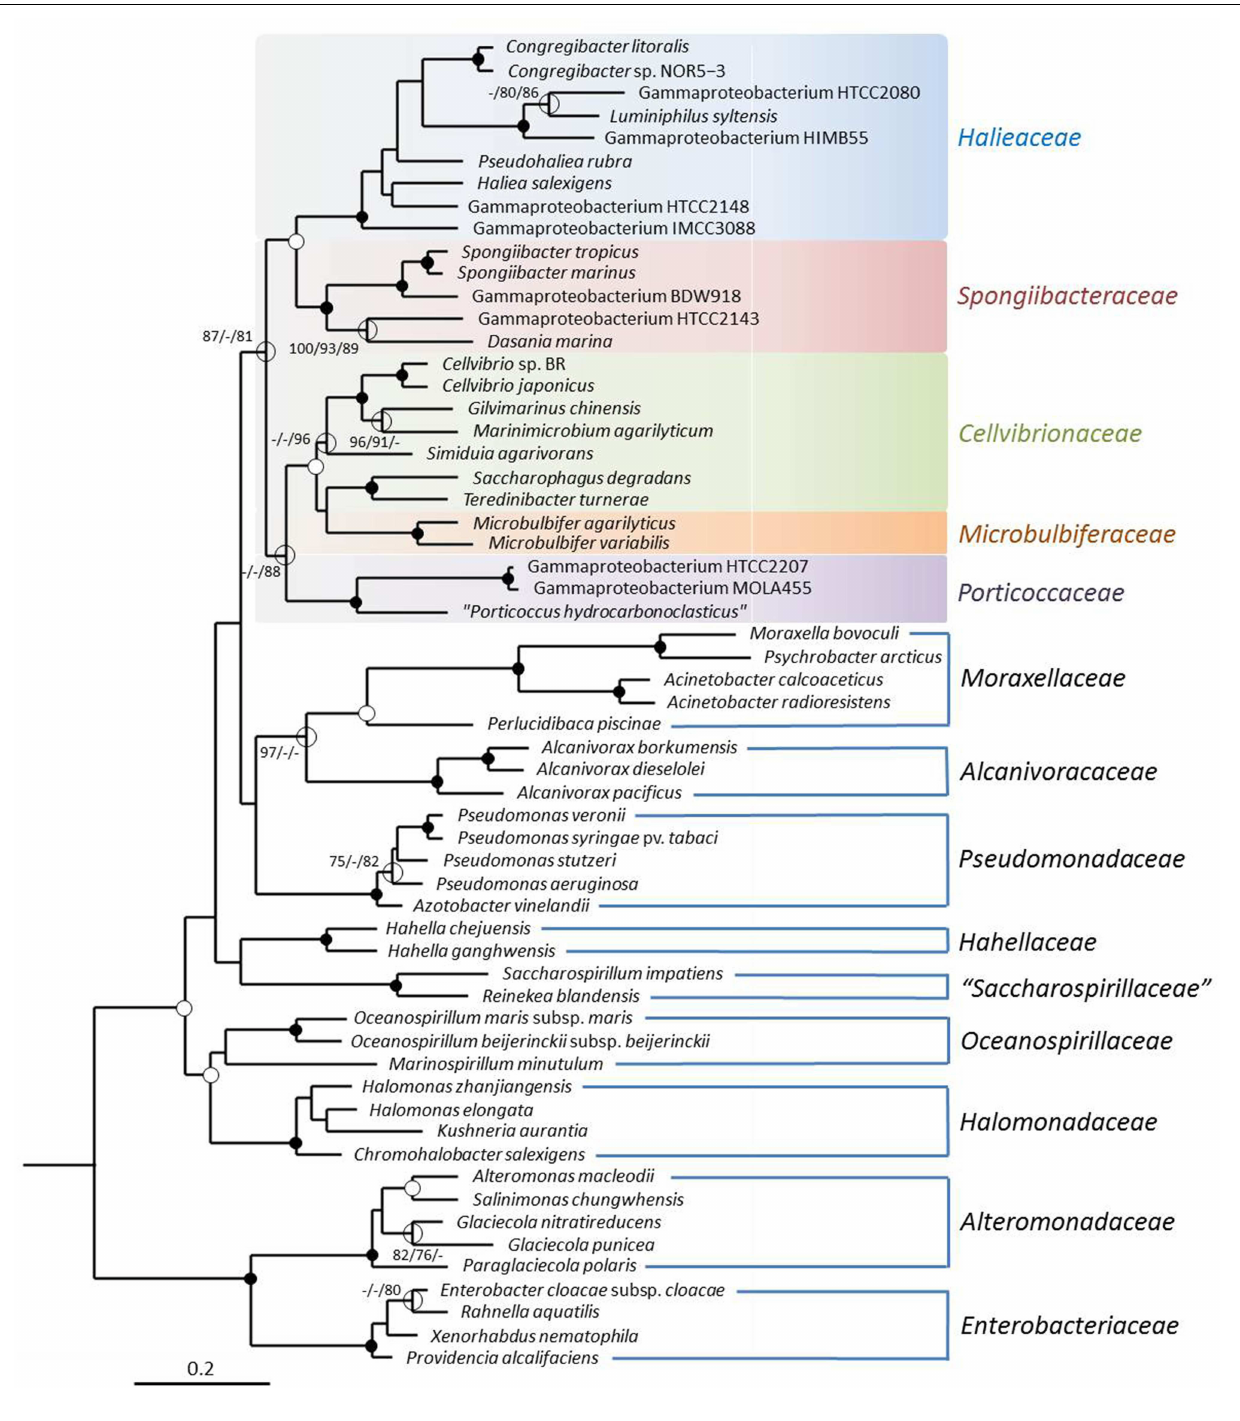
FIGURE 1 | Phylogenetic tree inferred from a dataset of complete RpoB protein sequences. The tree topology was reconstructed with the maximum-likelihood method using the PROTCATLGF model. The RpoB sequence of Magnetococcus marinus MC-1 T was used as an outgroup (not shown). Additional trees were reconstructed using maximum parsimony and neighbor-joining methods. Support of a distinct branching by bootstrap analyses is indicated by symbols. Black dots at a distinct node indicate that bootstrap values of 95% or above (percentages of 1000 resamplings) were